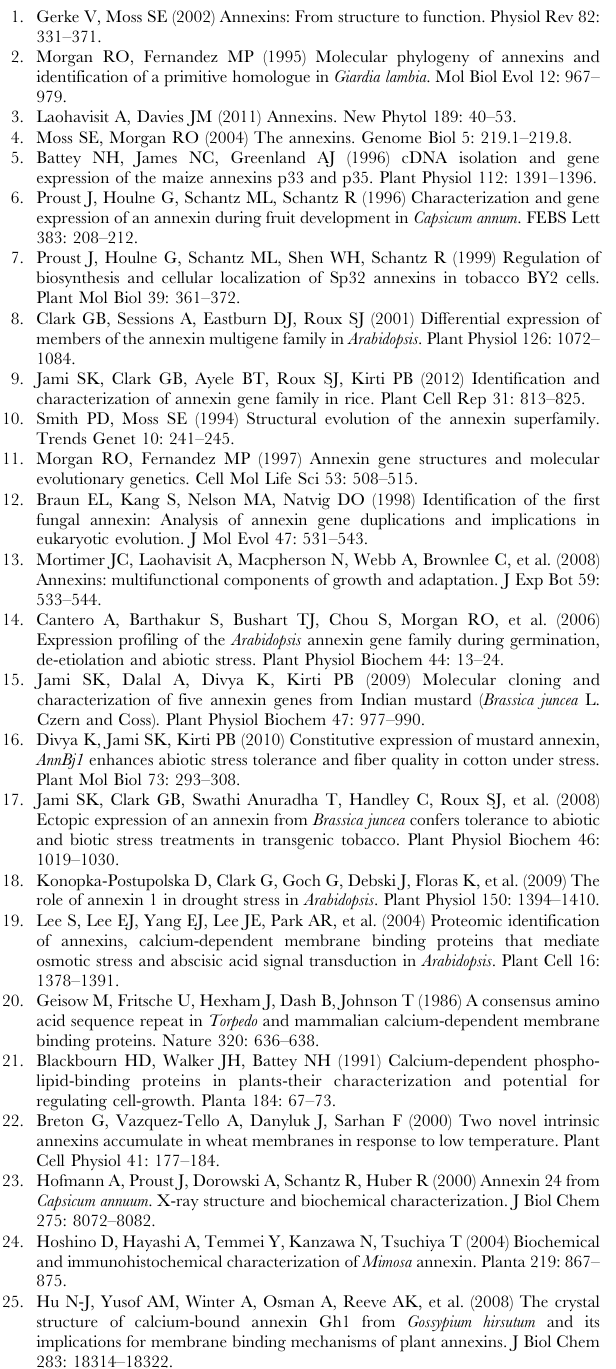
Table S1 Summary of 149 annexin genes identified in Viridiplantae and their sequence features. Table S2 Gene structure organizations in Spike moss, moss, Arabidopsis and rice showing the total number of